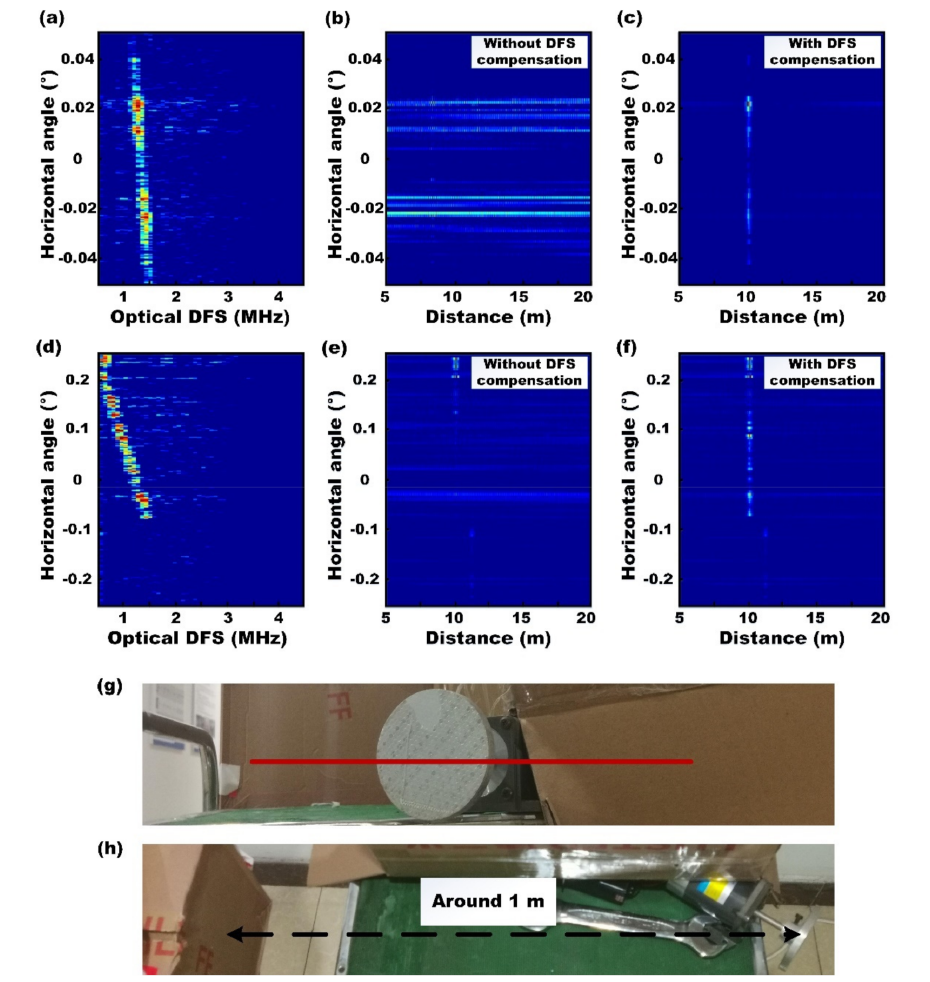
Figure 11. ( a – c ) Line-scanning measurements for a spinning disk with a 10-Hz scanning rate. ( a ) Real-time measured optical DFS. ( b , c ) are the correlation results without and with DFS com- pensation, respectively. ( d – f ) Line-scanning measurements for a target consisted of a spinning disk and static box with a 50-Hz scanning rate. ( d ) Real-time measured optical DFS. ( e , f ) are the correlation results without and with DFS compensation, respectively. ( g , h ) Photographs of the targets that consist of static boxes and a spinning disk. The red line indicates the scanning line. The distance between the box and the disk is around 1